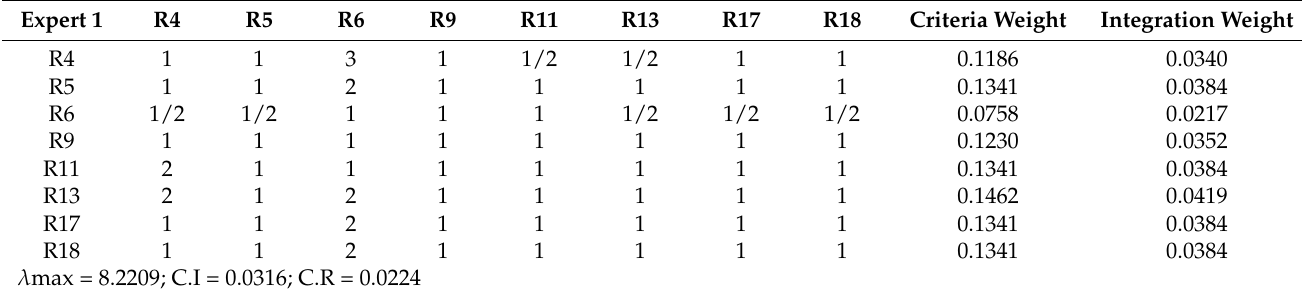
Table 11. The consistency and weight value of enterprise interiors and equipment (RA4) factors.